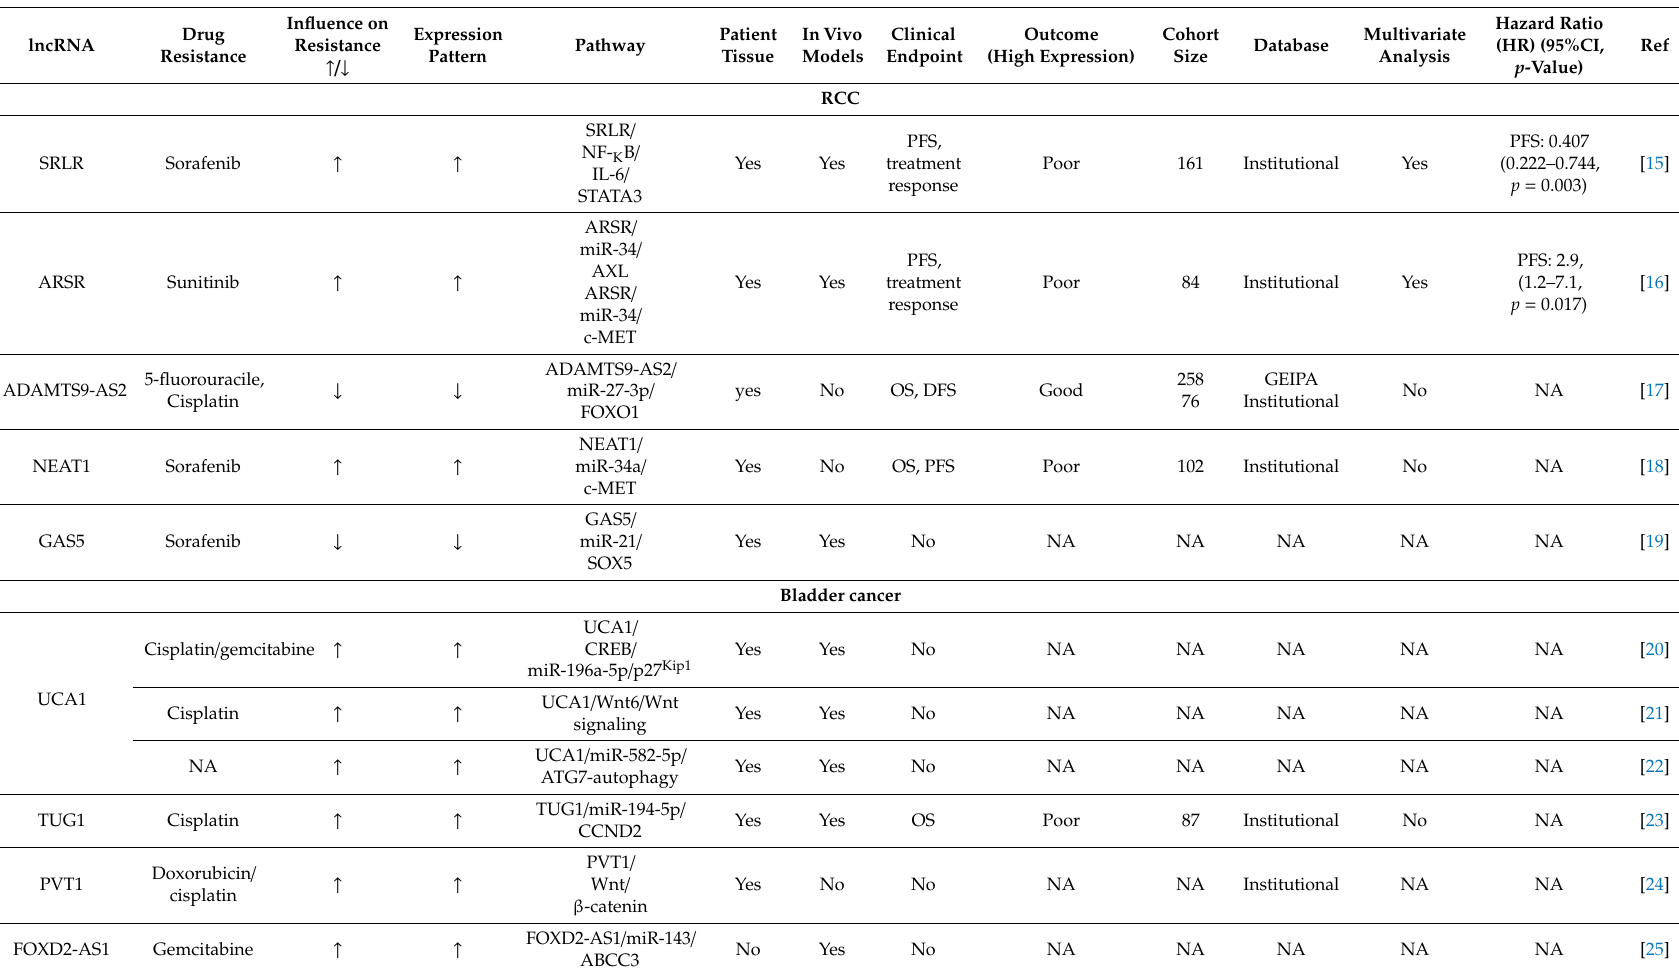
Table 1. Long non-coding RNAs (lncRNAs) associated with drug resistance in cancers of the genitourinary system: Abbreviations: RCC- renal cell carcinoma, OS—overall survival, PFS—progression free survival, DFS—disease-free survival, BRFS—biochemical recurrence free survival, NA—not applicable.